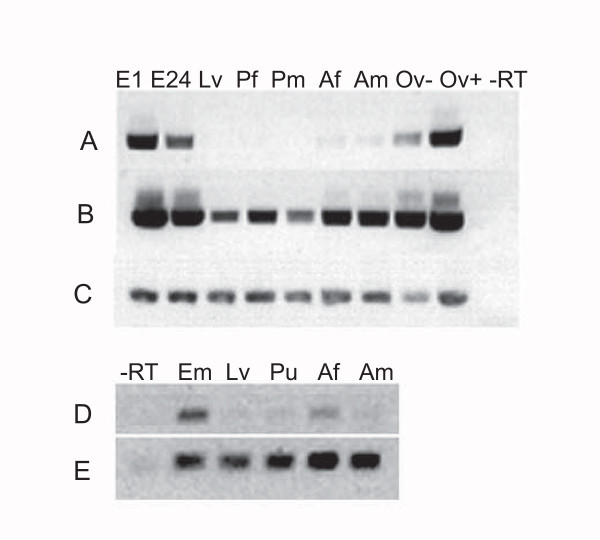
Developmental expression profile of CTCF protein in Ae. aegypti and D. melanogaster. The expression of CTCF was analyzed using RNA isolated from multiple individuals at each of the indicated stages: E1 and E24 (embryos ≤ 1 hr and 24 hrs post-oviposition respectively), Lv (larvae), Pf (female pupae), Pm (male pupae), Pu (pupae), Af (adult females), Am (adult males), Ov- and Ov+ (ovaries from non-blood-fed and blood-fed females respectively). -RT, no reverse-transcriptase. A. and B.) Ae. aegypti CTCF, 20 cycles and 30 cycles respectively. C.) Ae. aegypti S17, 25 cycles. D.) D. melanogaster CTCF, 25 cycles. E.) D. melanogaster Rp49, 20 cycles.